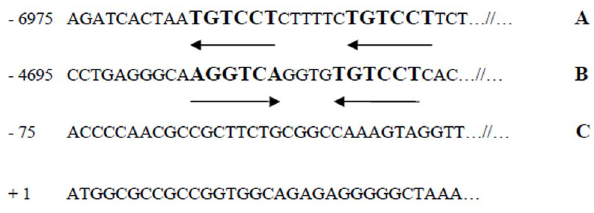
Figure 3. Selected sequence of the human Munc18c 5 9 -flanking region derived from the NCBI Reference Sequence NC_000001.10. The sequence of the human Munc18c 5 9 -flanking region ( , 7 kb) is shown with the LXR response elements (LXREs) denoted by arrows. These LXREs contain a (A) direct repeats (DRs) of the AGGACA half-sites spaced by 6 bp, and (B) inverted repeats (IRs) of AGGTCA and AGGACA half-sites spaced by 4 bp. (C) The putative transcription start site at 2 75 is